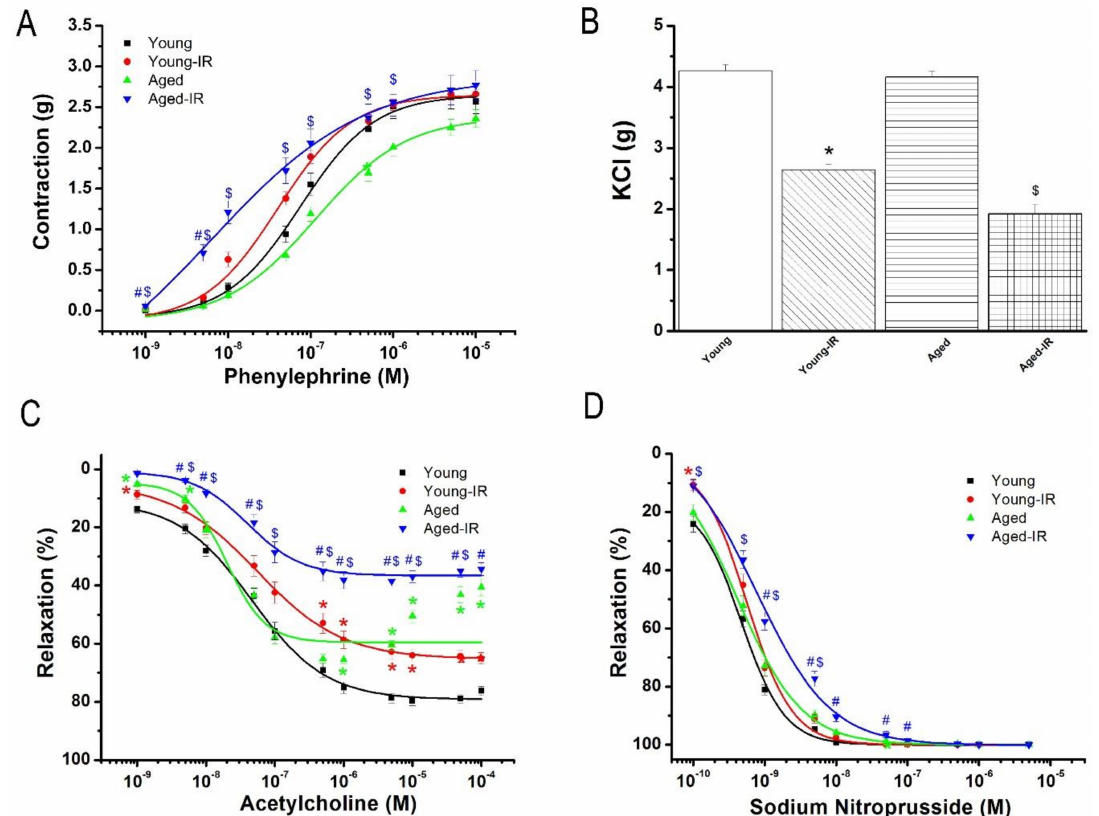
Figure 2. Effect of ischemia/reperfusion (IR) injury on contractile and relaxation responses. Contractile responses ( A ) for phenylephrine and ( B ) to high potassium K + -induced depolarization, and ( C ) acetylcholine-induced endothelium-dependent and ( D ) for sodium nitroprusside-induced endothelium-independent vasorelaxation of isolated thoracic aortic rings in young and 15-month-old rats. KCl indicates potassium chloride. Data are represented as mean ± SEM. * p < 0.05 vs. young, # p < 0.05 vs. young-IR, $ p < 0.05 vs. aged.